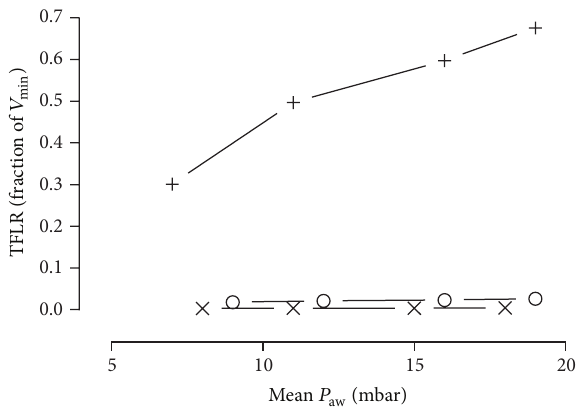
Figure 5: Transfenestration leakage rates of Portex Blue Line Ultra (+), TRACOE twist ( × ), or R¨usch Traceofix ( I ) tracheostomy tubes plotted against increase in mean airway pressures. Measurements were obtained in volume-controlled ventilation (ventilator rate: 15 breaths ⋅ min −1 , tidal volume: 450 mL) at 37 ± 1 ∘ C. Lung simulator compliance: 20 mL ⋅ mbar −1 . TFLR: transfenestration leakage rate; 𝑉 𝑃 aw : mean airway pressure; min : minute ventilation.